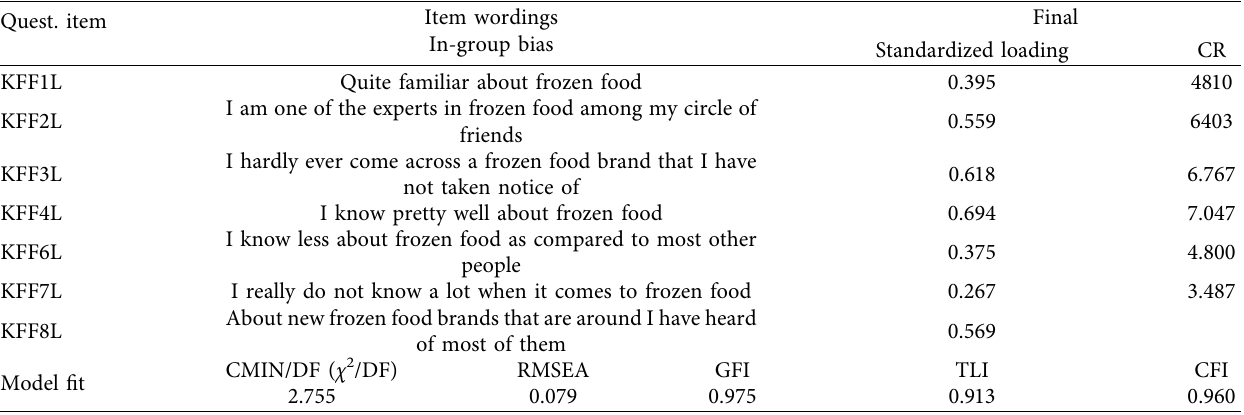
Table 4: Model fit summary (confirmatory factor analysis of knowledge about fast food).